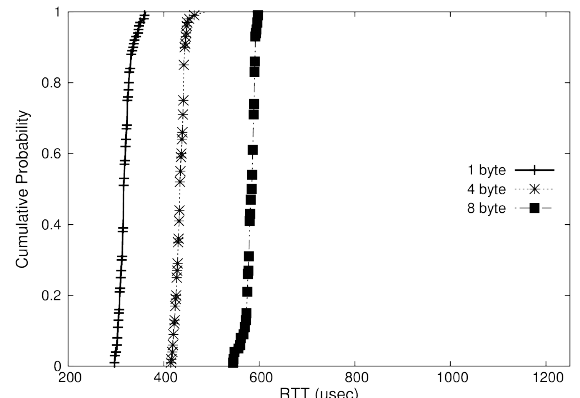
Figure 10. CDF of RTT in a hypervisor-based virtualization